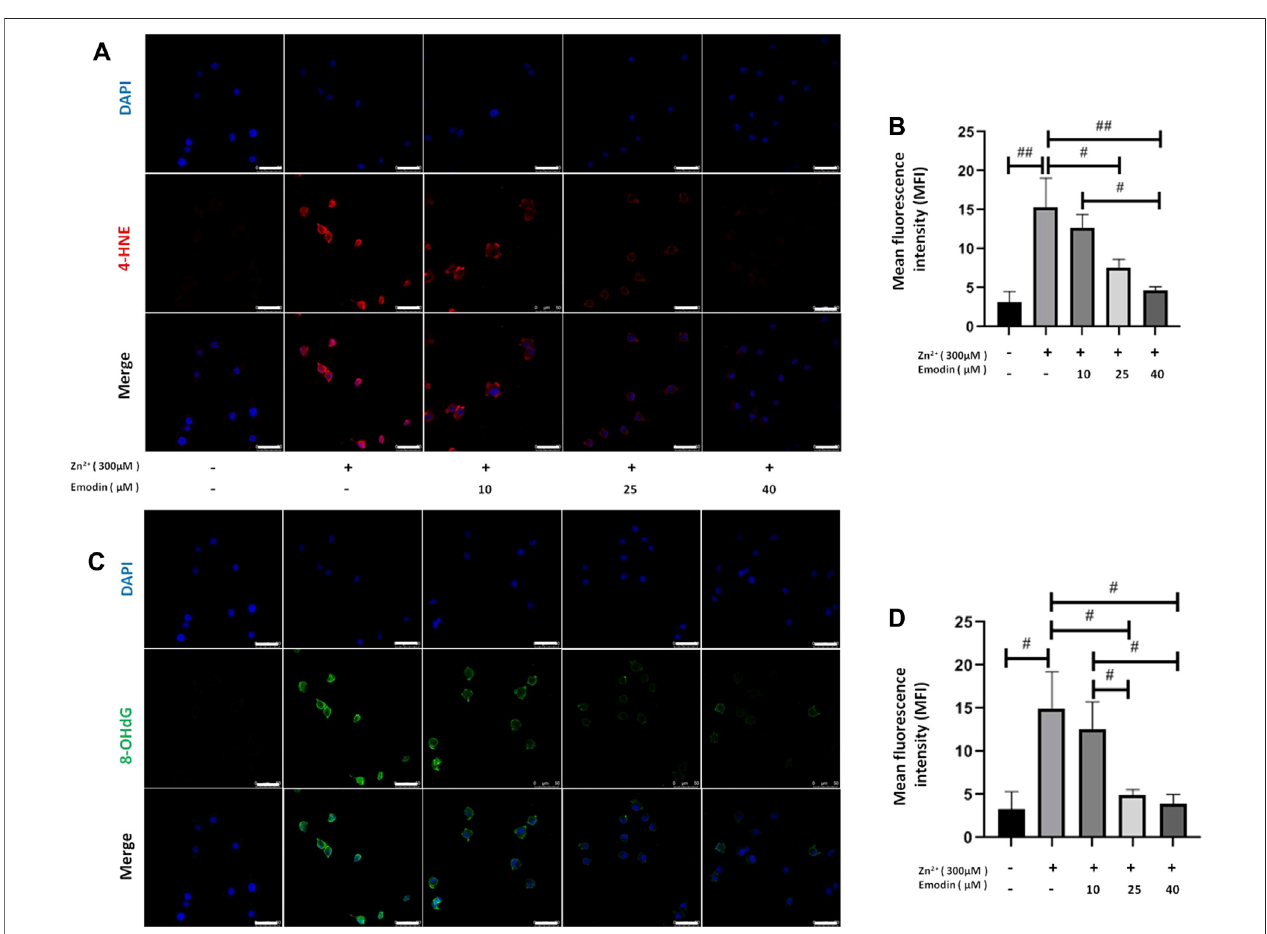
FIGURE 4 | Emodin repressed lipid peroxidation and DNA oxidation in zinc-treated SH-SY5Y cells. (A, C) Immuno fl uorescence-based confocal images of 4- hydroxynonenal (4-HNE, red) and 8-hydroxy-2 ′ -deoxyguanosine (8-OHdG, green) in untreated and 300 μ M zinc sulfate-treated cells, with or without pretreatment with different concentrations of emodin with or without pretreatment with emodin (10, 25, and 40 μ M). Scale bar = 50 μ m. Nuclei were stained with DAPI (blue). (B, D) Mean fl uorescence intensity analysis. One-way ANOVA and Bonferroni post hoc analysis, # p < 0.05, ## p < 0.001; Data are presented as the mean ± SEM.